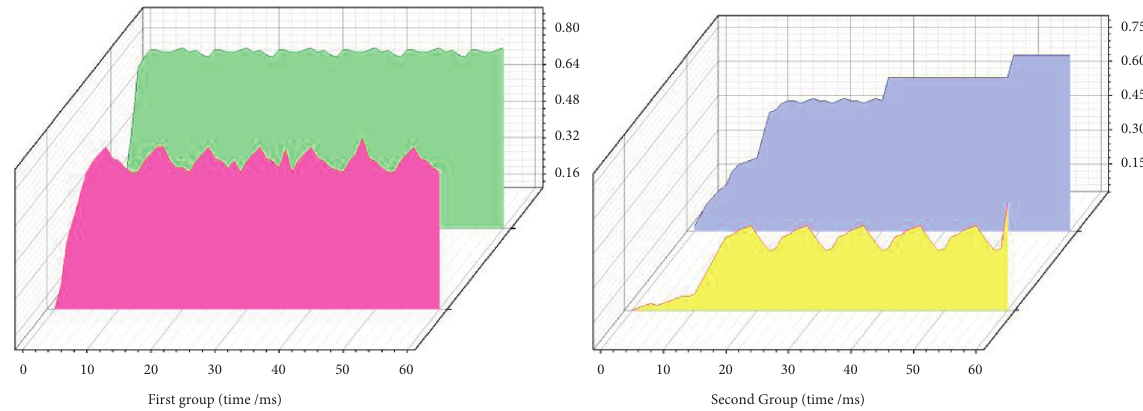
Figure 7: Obstacle avoidance algorithm simulation